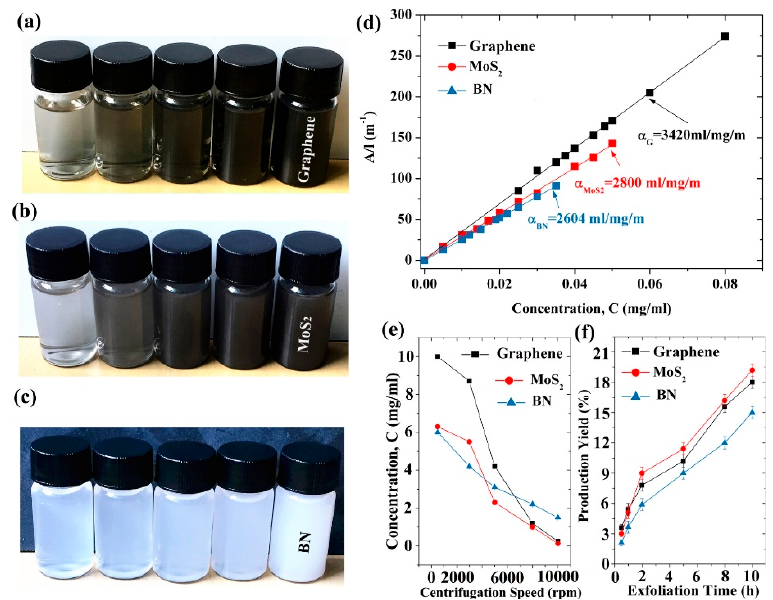
Figure 25. Photographs of aqueous dispersions of graphene ( a ), MoS 2 ( b ), and BN ( c ) with different concentrations after centrifugation at 500–10,000 rpm for 30 min; ( d ) Lambert – Beer plots for graphene, MoS 2 , and BN; ( e ) dependence of 2D material concentration on centrifugation speed for the supernatant; ( f ) dependence of 2D material production yield on exfoliated time. Reproduced from [53]. Copyright IOP Publishing, 2017.